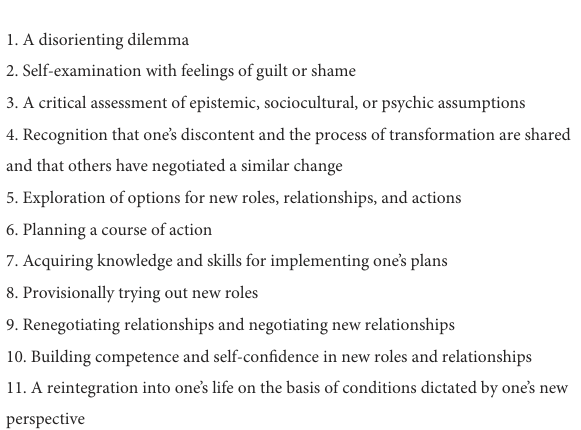
TABLE 1 Mezirow’s Phases of